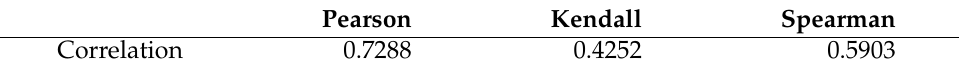
Table 3. Sample linear and rank correlation coefficients.